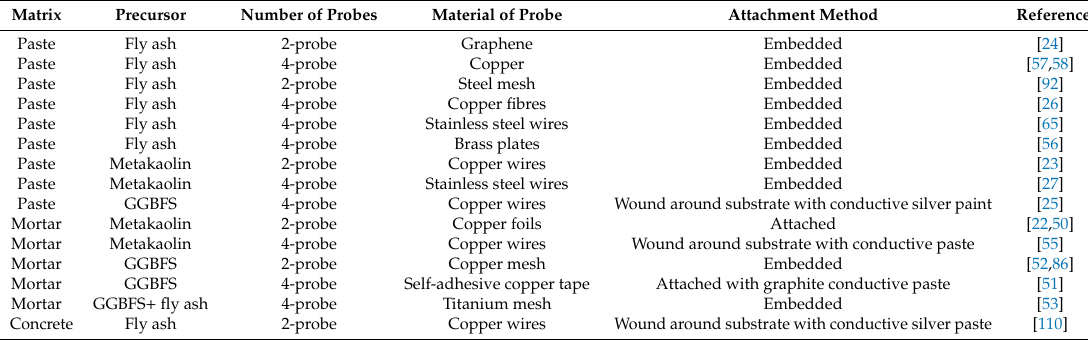
Table 2. Electrode configuration for AAM sensing